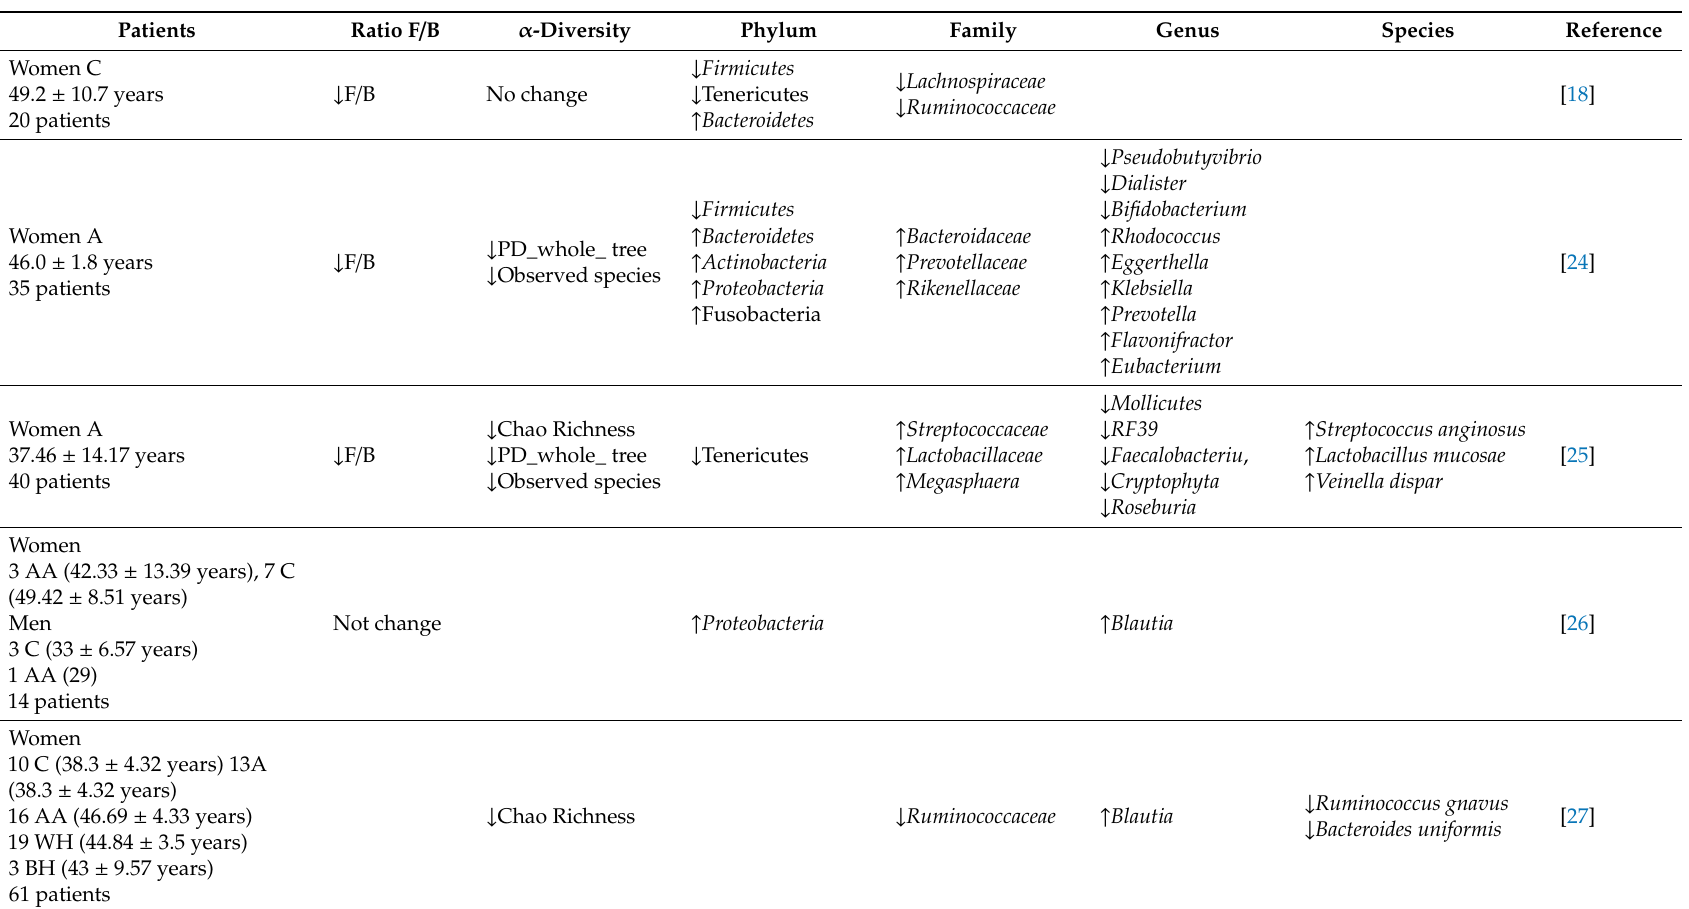
Table 1. Gut microbiota shifts in systemic lupus erythematosus (SLE)